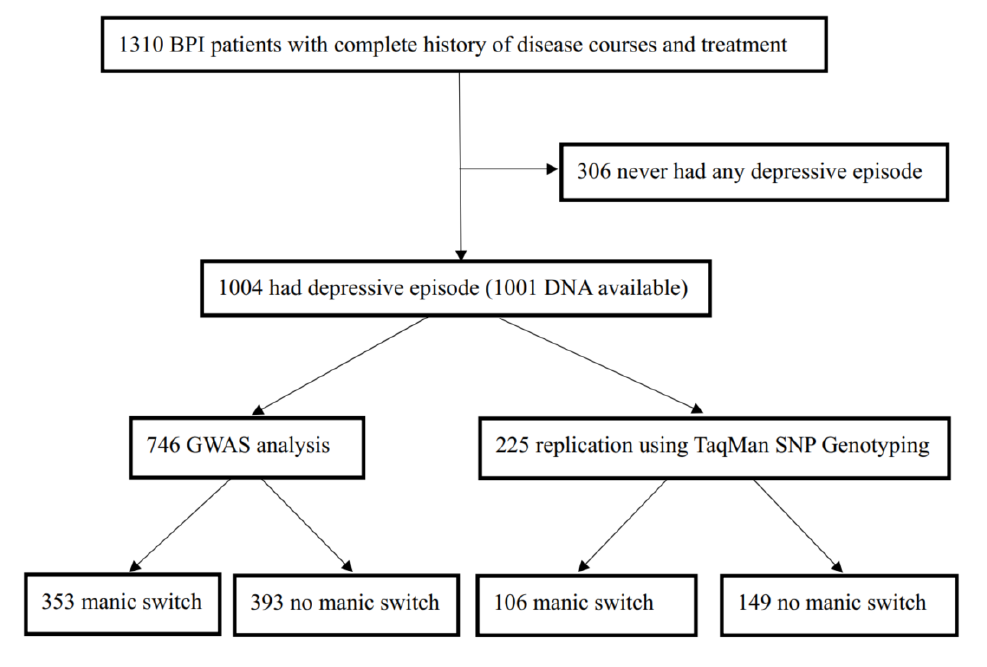
Figure 1. Case selection profile. Table 1. Demographic and clinical characteristics, comparing statistics of study patients with bipo- lar I disorder.